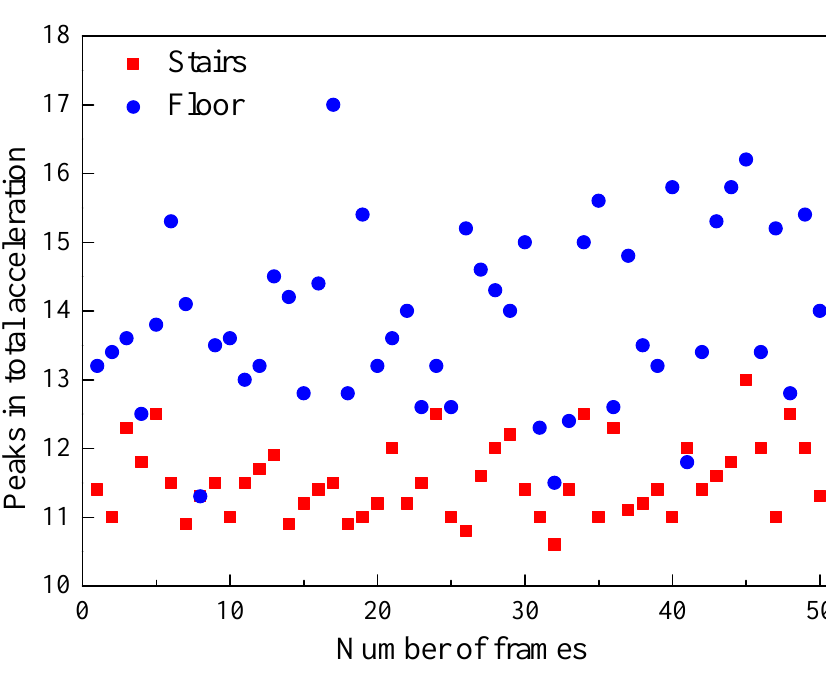
Figure 8. Peak of total